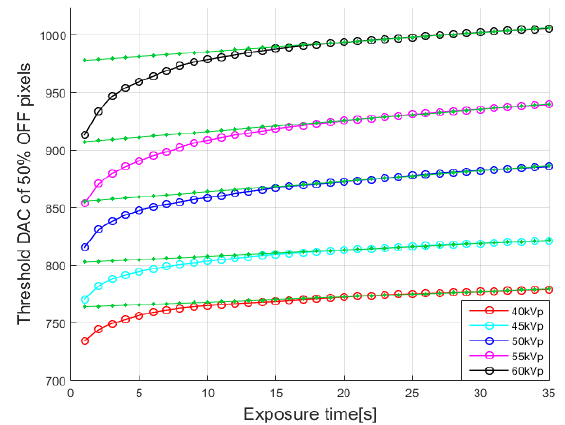
Figure 5. The transition threshold corresponding to 50% OFF pixel at 40, 45, 50, 55 and 60 kVp and at 200 μ A. The green lines are linear fits to the parts of the curves after 15 s.